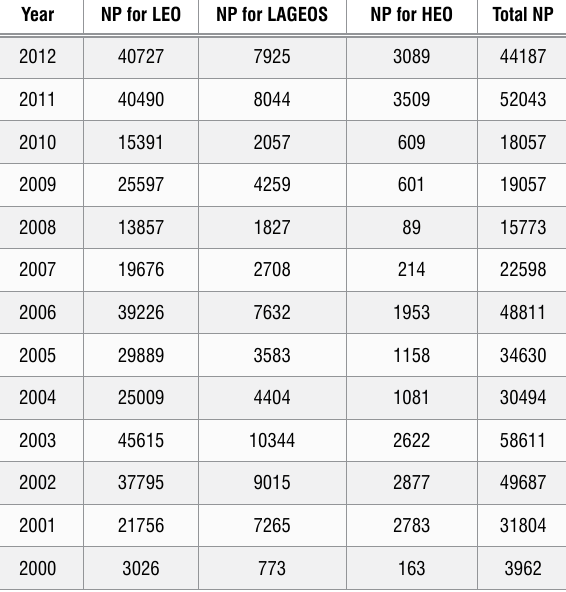
MOBLAS-6 performance parameters based on data volume. Low Earth Orbiter (LEO) data surpasses the higher satellites, as they are much easier to range to due to their lower orbital